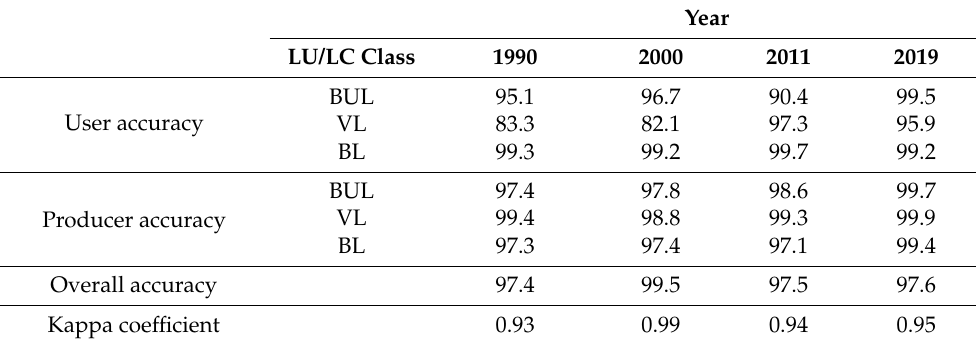
Table 4. Accuracy of Mashhad city LU/LC classification for the period of 1990–2019 for built-Up land (BUL), vegetation land (VL), and bare land (BL) classes.